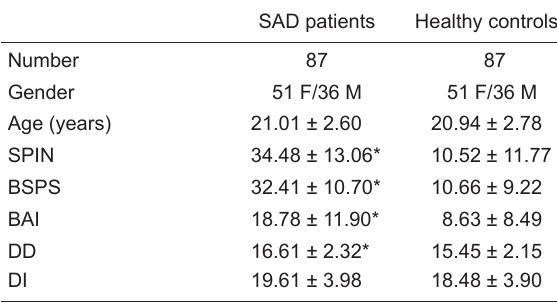
Table 2. Characteristics of the sample.